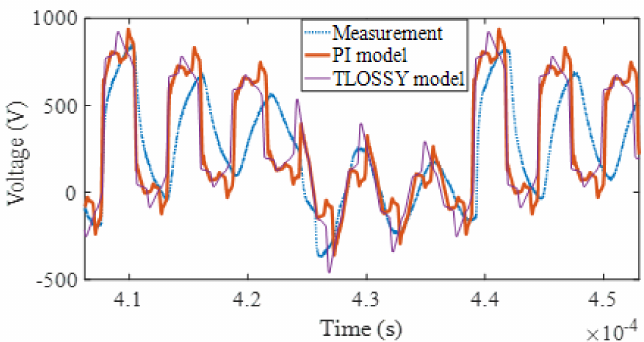
Figure 10. Comparation of the line-to-line overvoltage at the motor side with the PI model and TLOSSY model.